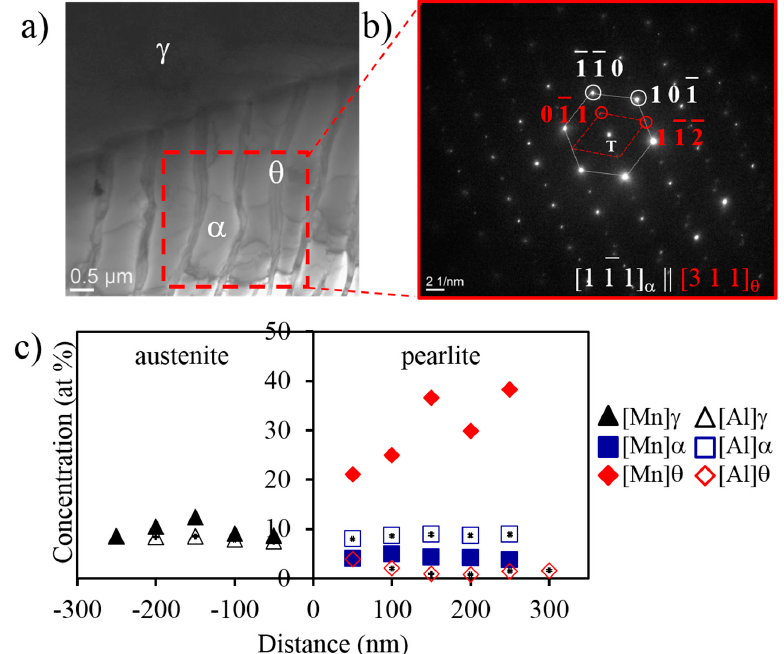
Figure 5. ( a ) TEM image showing the γ / α and γ / θ interfaces in pearlite obtained at 670 °C after 3 days. White dashed lines indicate where the measurements were carried out; ( b ) the corresponding selected area diffraction pattern for the pearlite colony presented in (a)—(white) the diffraction spots from ferrite and (red) from cementite; ( c ) ATEM measurements of Mn and Al across the γ / α and γ / θ interfaces. Materials 2016 , 9 , 998